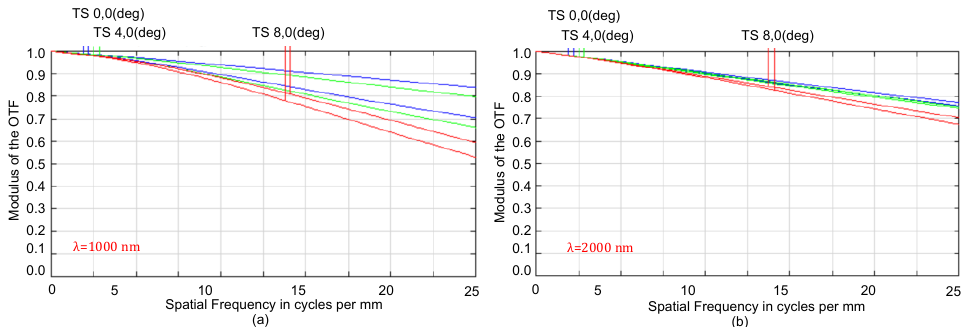
Figure 4. MTF curves of the spectrograph at wavelengths of ( a ) 1000 nm and ( b ) 2000 nm.